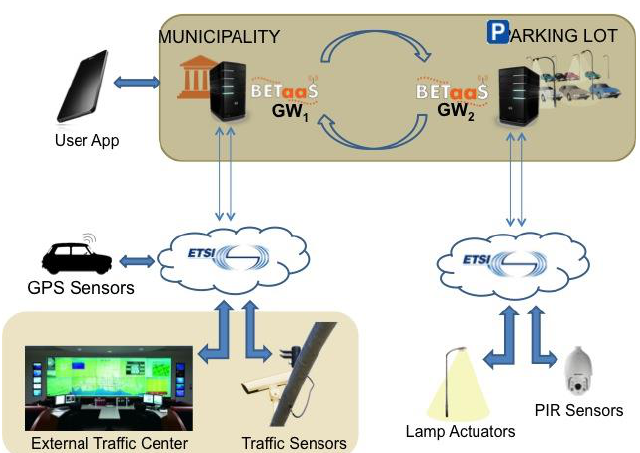
Figure 2. Smart city scenario deployment on BETaaS